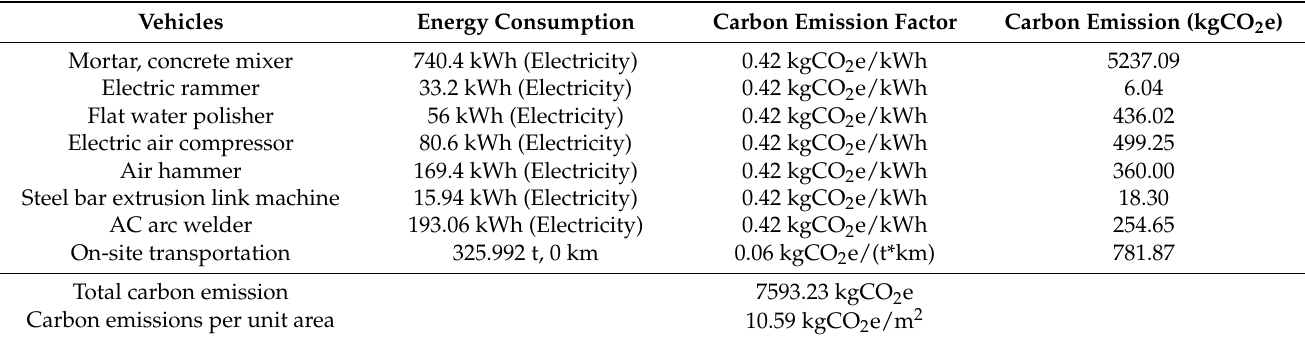
Table 3. Construction carbon emission of refurbished buildings.